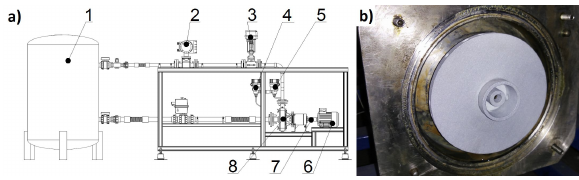
Figure 3: Presentation of test rig – (a) Test rig scheme and (b) the model pump without the front panel. Description of test rig scheme: 1 – tank, 2 – flowmeter, 3 – ball valve, 4,5 – pressure detectors, 6 –